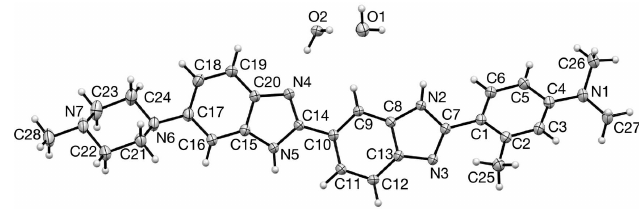
Figure 1 Displacement ellipsoid plot of the asymmetric unit for dihydrate (1) (cid:2) 2H 2 O.